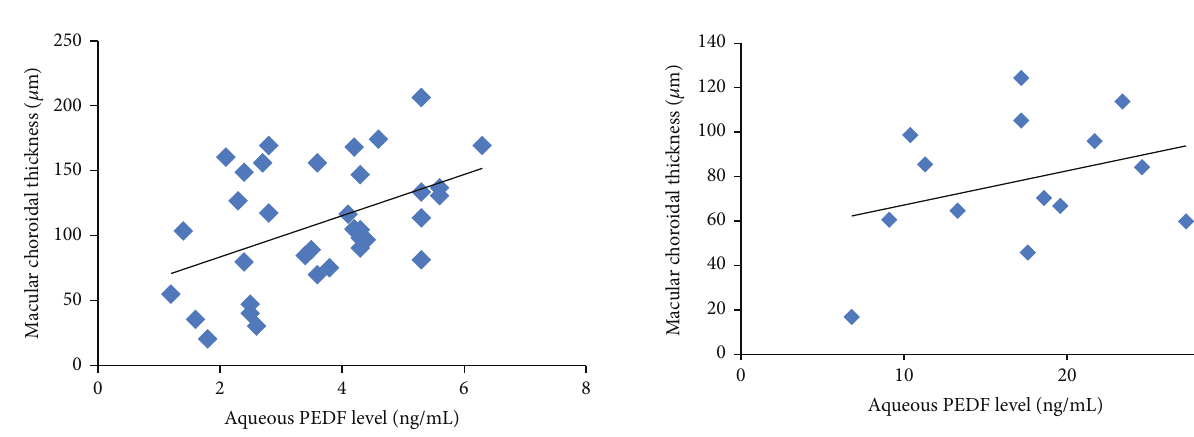
Figure 4: Scatterplots of aqueous PEDF levels and macular choroidal thickness in the CNV group show no correlation ( R 2 = 0.108; y = 1.5162 x + 51.404; 𝑃 = 0.214